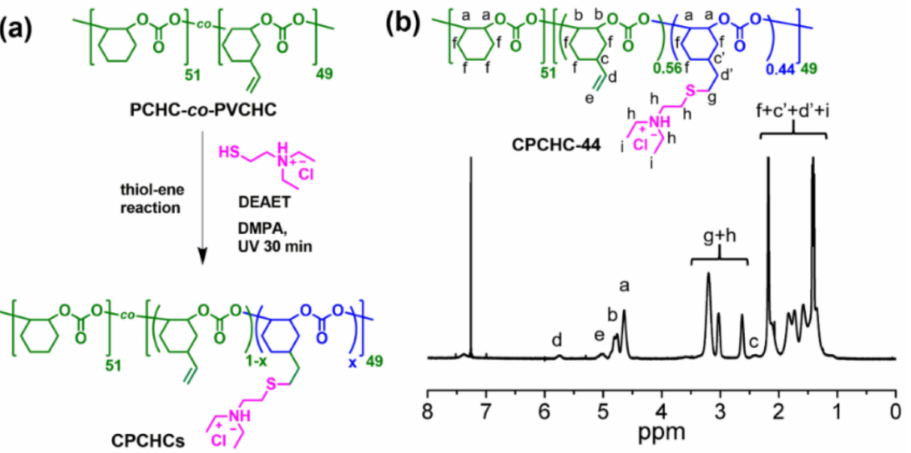
Figure 1. Synthesis and chemical structure of CPCHC44. ( a ) Synthetic route of CPCHCs. ( b ) 1 H-NMR spectrum of